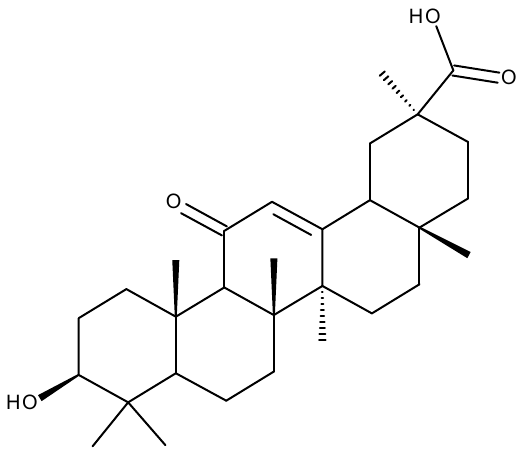
Figure 10. Structure of glycyrrhetinic acid.